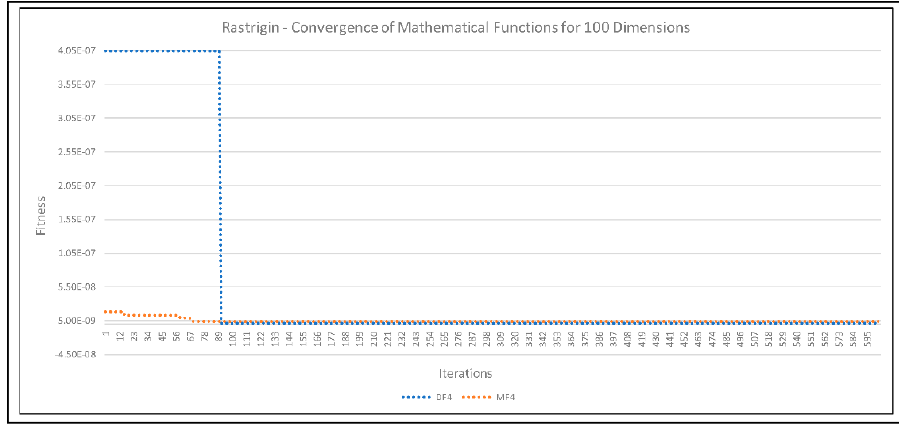
Figure 10. Convergence of the DMOA and MTOA algorithms for 50 dimensions, for the func- tions F2, F3, and F4. Figure 11. Convergence of the DMOA and MTOA algorithms for 100 dimensions, for the func- tions F3, F4, and F5.